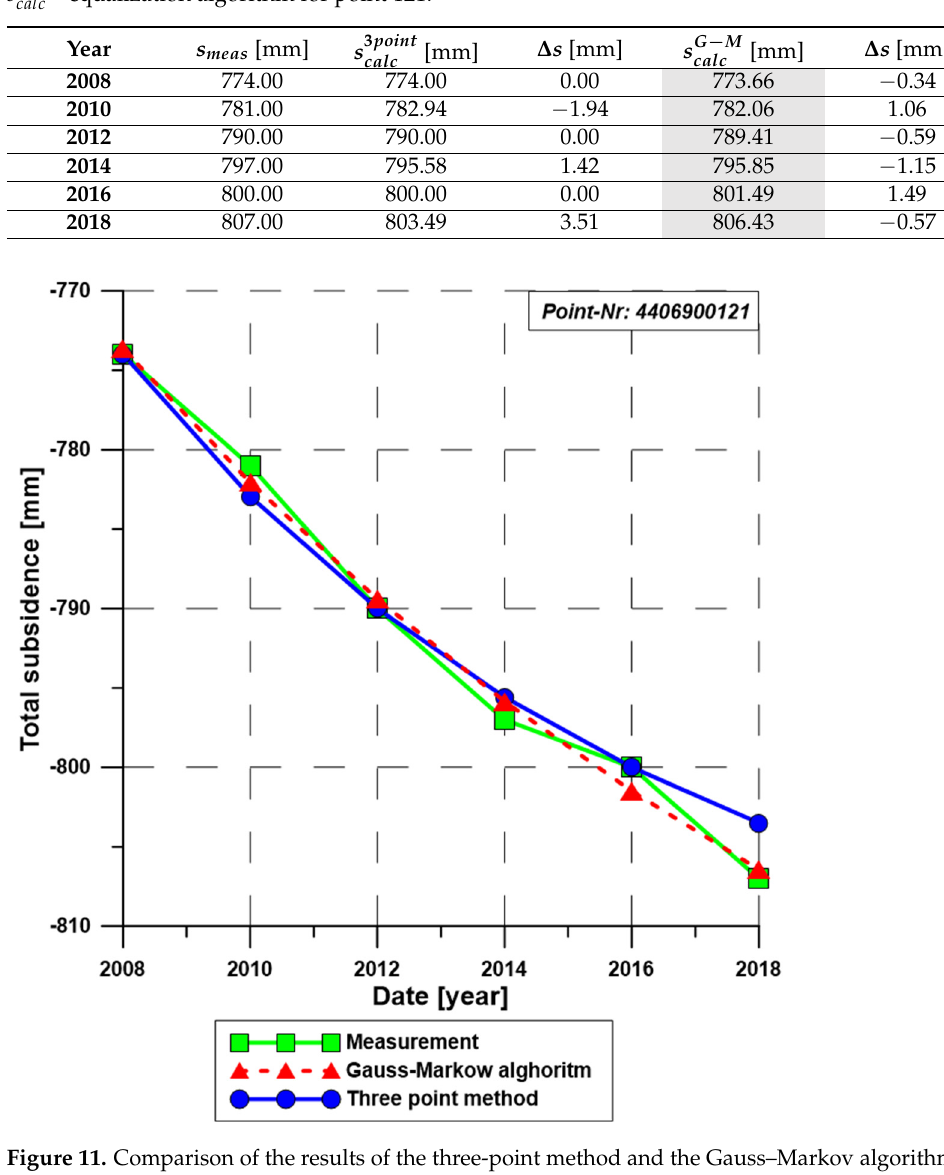
and Gauss–Markov calc